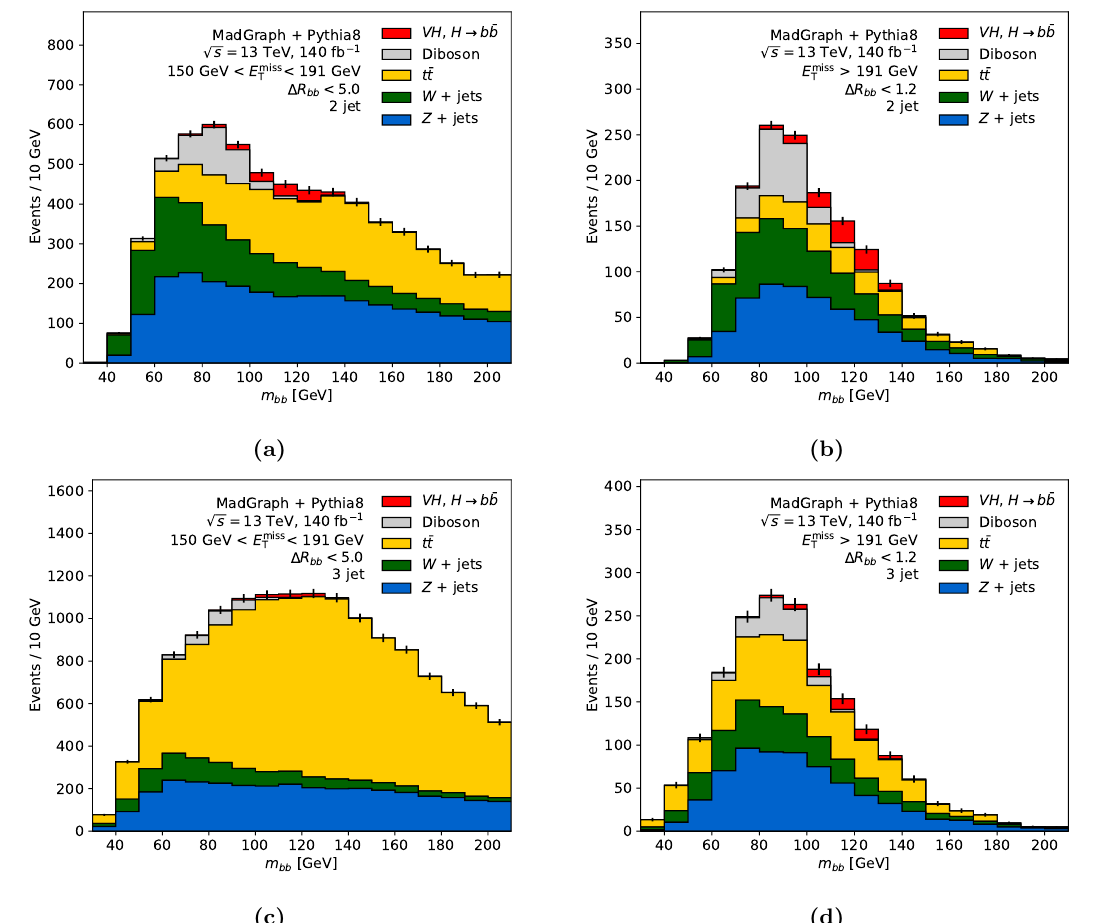
Figure 1 . CBA categories. The m bb distribution is shown in the two-jet low- E miss E miss (b) categories, as well as in the three-jet low- E miss T events are shown in red, while backgrounds are shown in blue ( Z +jets), green ( W +jets), yellow ( t (cid:22) t ), and gray (diboson). Error bars show the statistical uncertainty on the total MC prediction and are dominated by the uncertainty on the